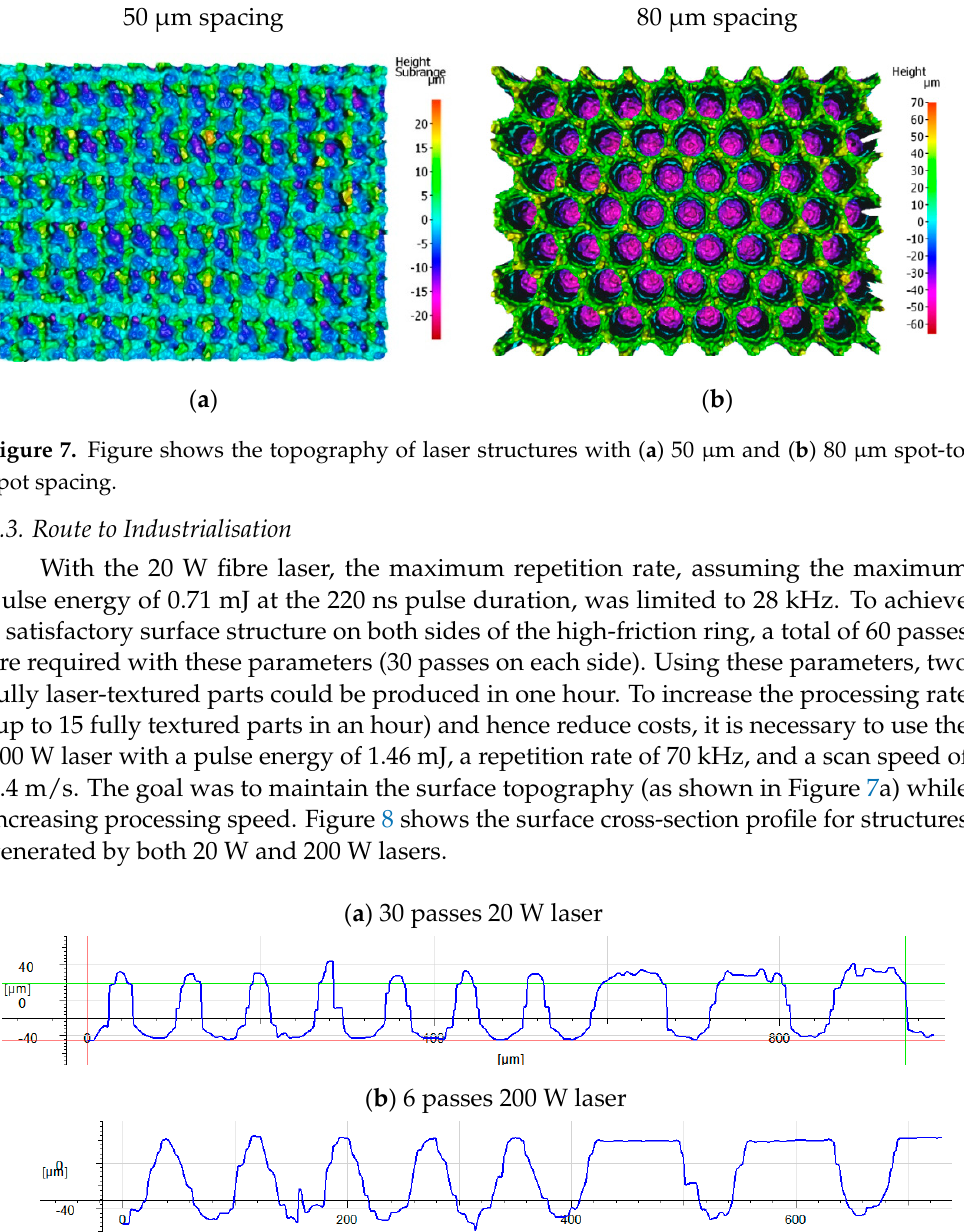
Figure 6. Height of the two key points between adjacent craters. The maximum pulse energy used was 0.71 mJ.